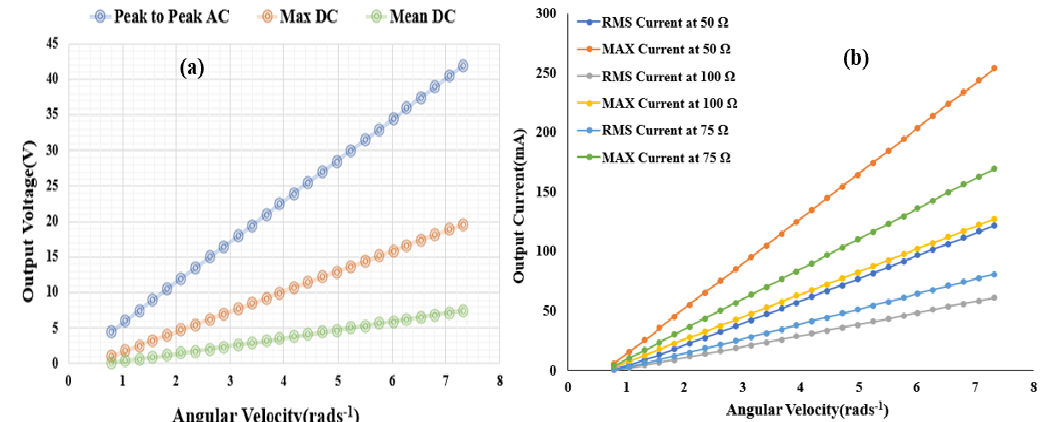
Figure 9. The response of energy harvester via angular velocity of rotor. ( a ) Output voltage, ( b ) Output current.